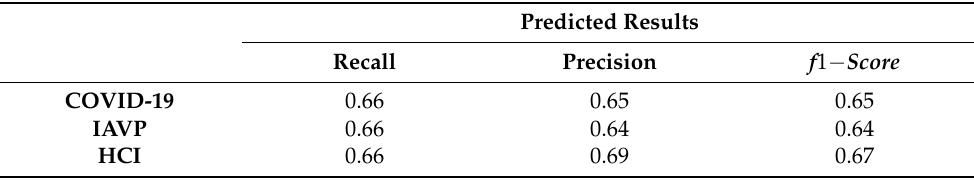
Table 4. Model performance evaluation metrics on recall, precision, and f1-score of both classification models for COVID-19, IAVP, and a Healthy Candidate without infection (HCI).